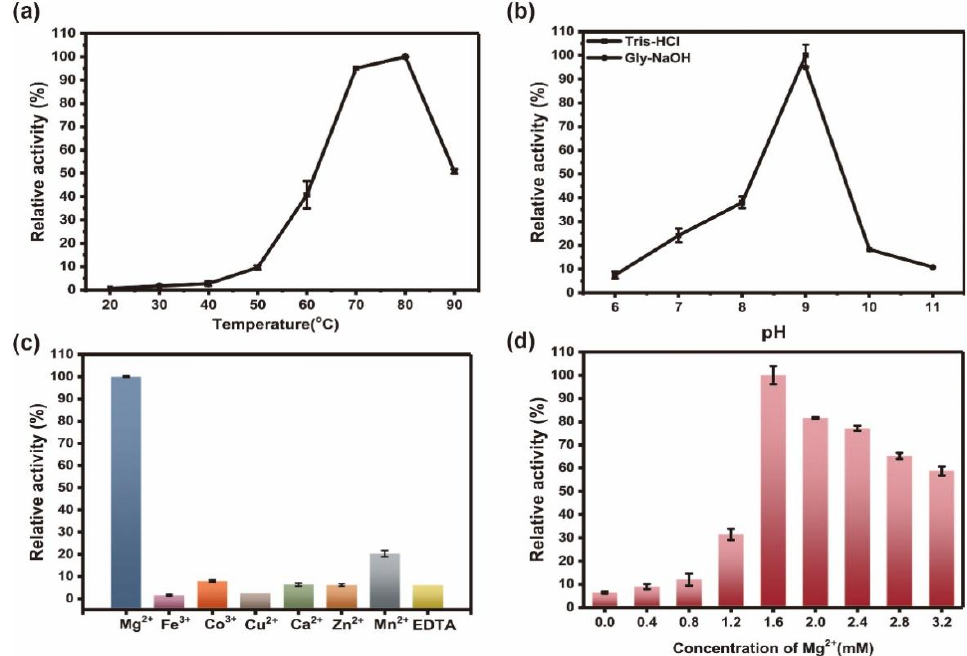
Figure 2. Characterization of Ton1914. ( a ) The optimum temperature of Ton1914 detected at 50 mM Tris-HCl buffer (pH 9.0); ( b ) The optimum pH of Ton1914 detected at 80 °C; ( c ) The effect of different metal ions and EDTA (final concentration 2 mM) on Ton1914; ( d ) The effect of Mg 2+ concentration on Ton1914.